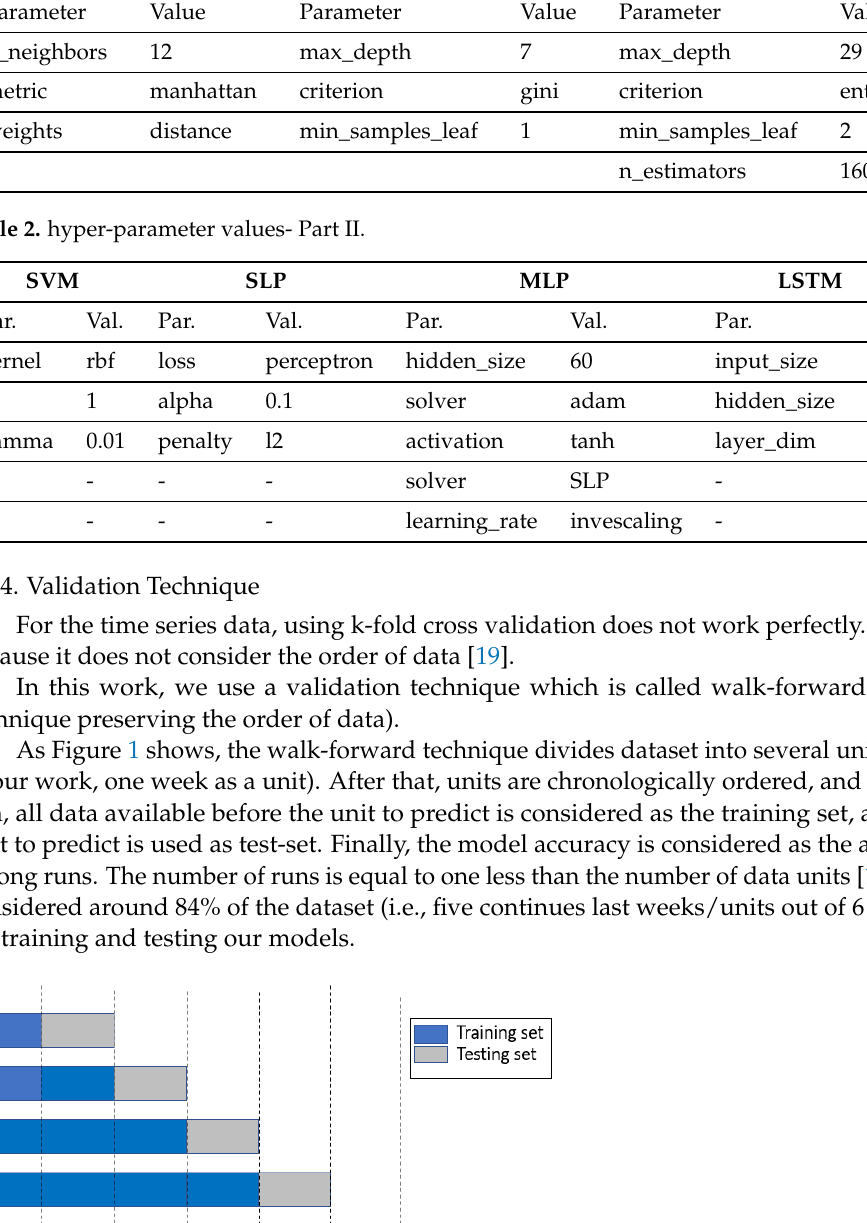
Table 1. hyper-parameter values- Part I. KNN Decision Tree Random Forest Parameter Value Parameter Value Parameter